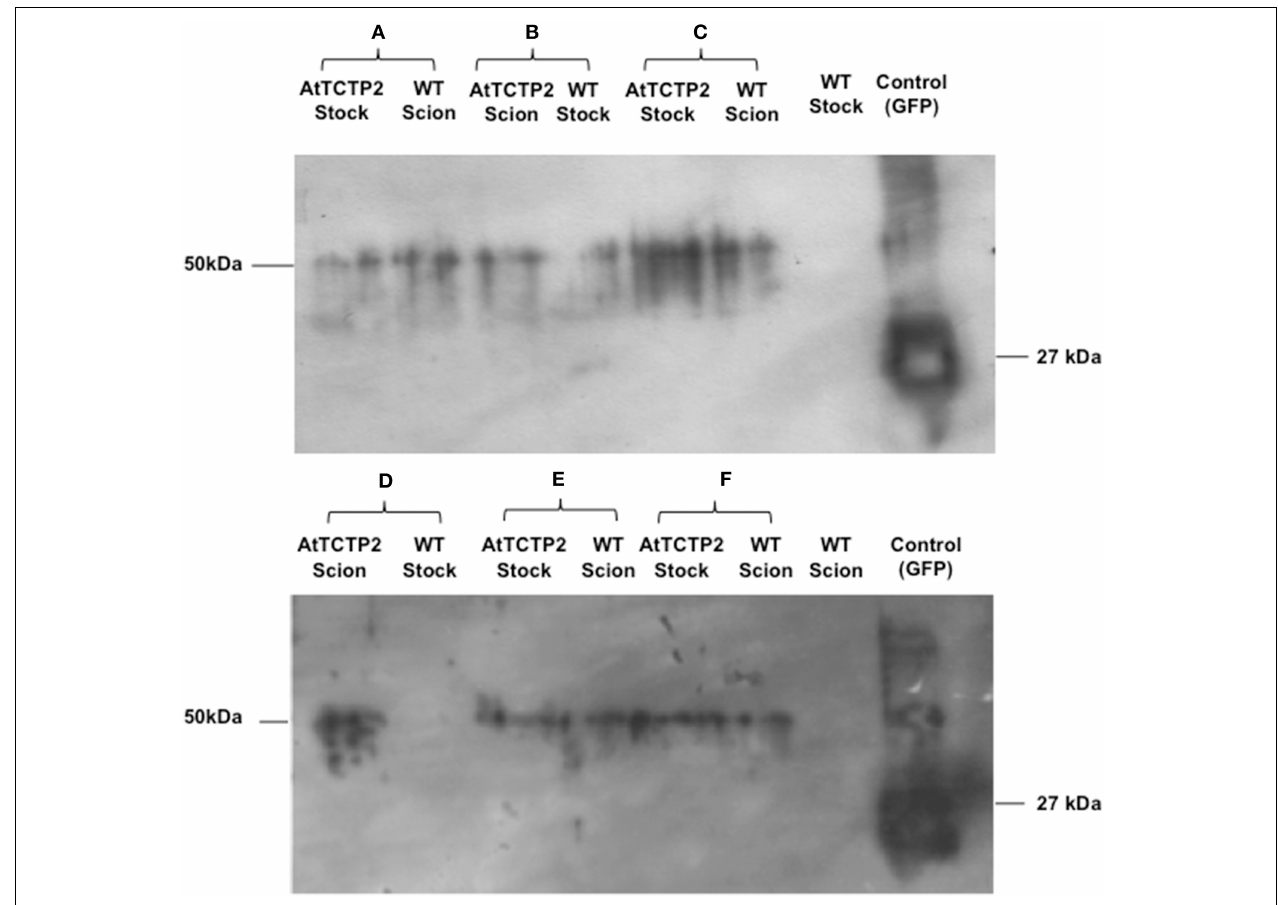
FIGURE 3 | AtTCTP2-GFP protein moves long distance in tobacco grafts. Inmunodetection was performed to detect GFP fused to AtTCTP2 from scions and stocks for each graft tested. Panels (A,C,E,F) are examples of the fusion protein long-distance movement (AtTCTP2-GFP = 50kDa) from